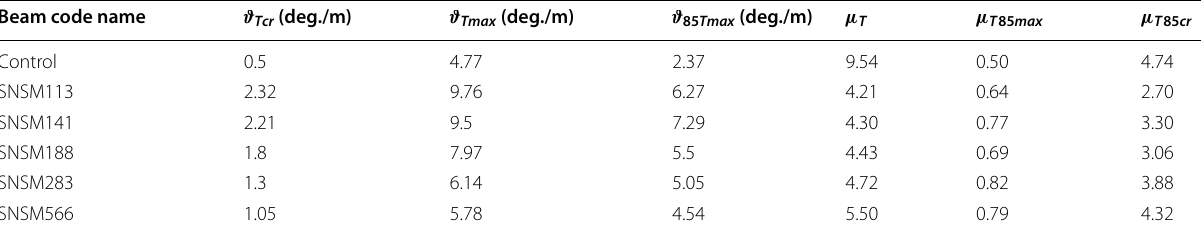
Table 6 Torsional ductility